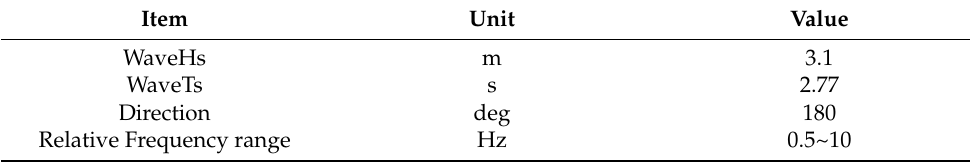
Table 5. Parameters of Jonswap spectrum in normal operating